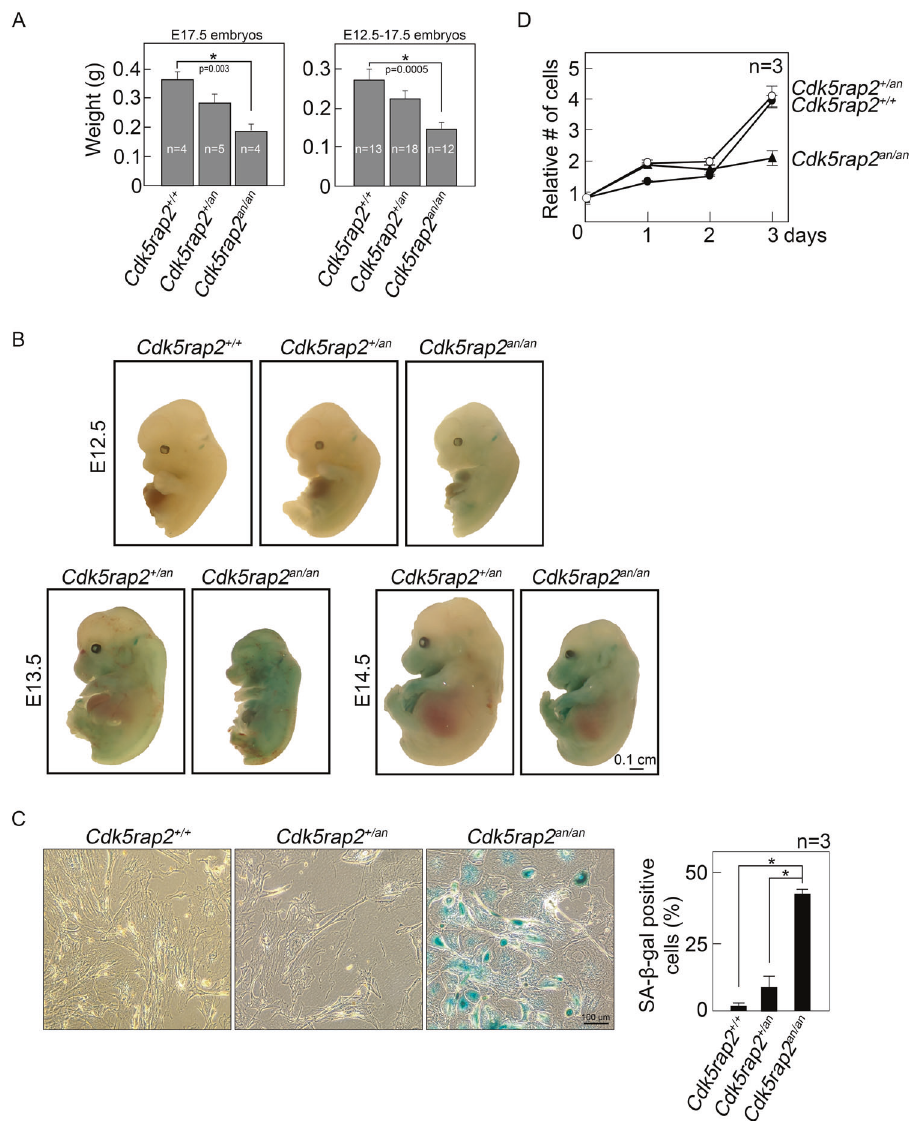
Fig. 2 Cdk5rap2 an/an embryos with reduced body weight exhibit elevated SA- β -gal staining compared to Cdk5rap2 + /an and Cdk5rap2 + / + embryos. A Average weights of isolated E17.5 (left panel) and E12.5 to E17.5 (right panel). Cdk5rap2 + / + , Cdk5rap2 + /an , and Cdk5rap2 an/an embryos from different litters are shown. B SA- β -gal staining of E12.5-E14.5 Cdk5rap2 an/an and Cdk5rap2 + /an and Cdk5rap2 + / + littermate embryos was performed as described in Materials and Methods. C MEFs isolated from Cdk5rap2 + / + , Cdk5rap2 + /an, and Cdk5rap2 an/an embryos were subjected to SA- β -gal staining. Representative images (left panel) are from one of three independent experiments ( n = 3) showing similar staining patterns. The number of SA- β -gal positive cells was assessed in ~200 cells per treatment group in each of the 3 independent